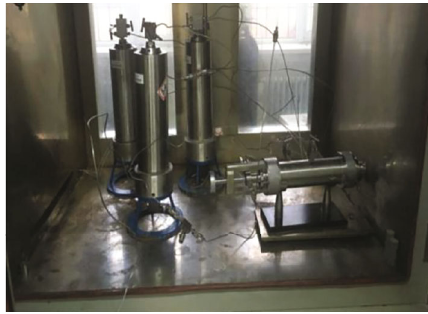
Figure 3: Schematic diagram of main experimental